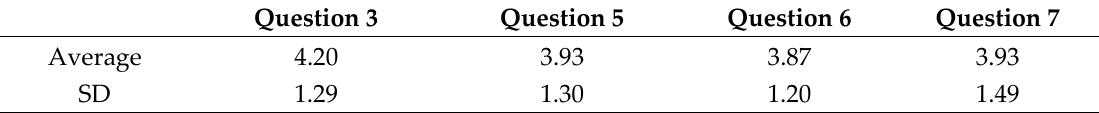
Table 3. Results of the questions replied with 5-point Likert scale for the gamification